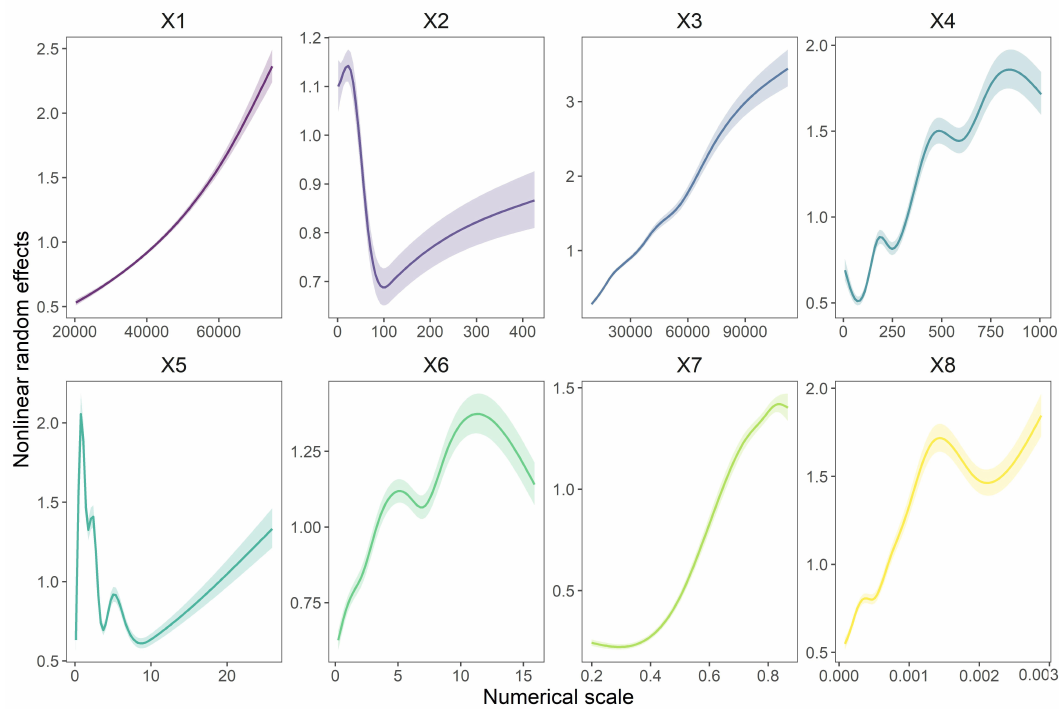
Figure 3. Global-scale nonlinear numerical effects of main drivers on China’s city-level tourism industry: X1—average wage of employed persons in urban units, X2—employment density of urban units, X3—GDP per capita, X4—population density, X5—nighttime light index, X6—slope, X7—NDVI, and X8—road network